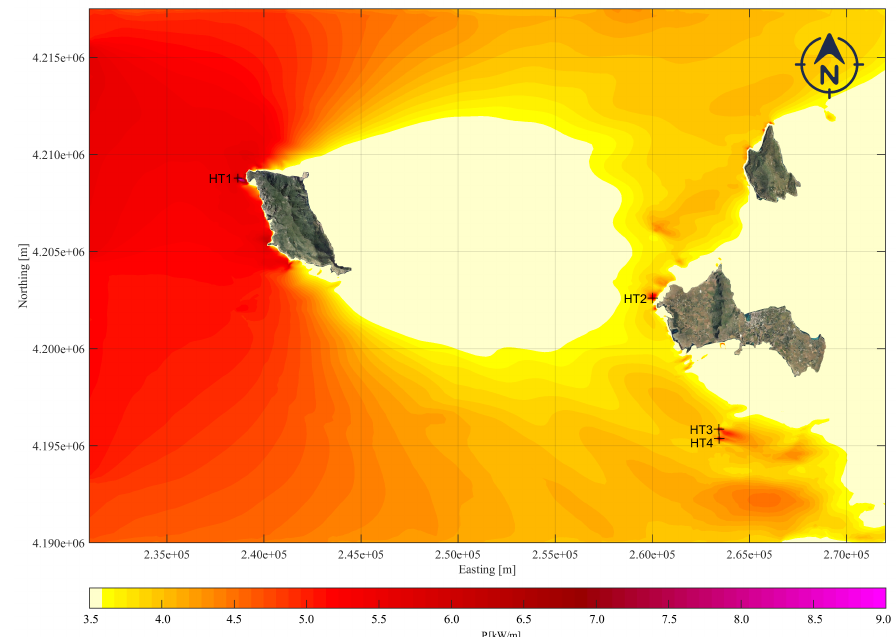
Figure 11. The four energetic hotspots of the Aegadian archipelago in the period between 2009 and 2010. The colour bar shows the mean yearly wave energy flux [kW/m], the crosses represent the hotspots HT1, HT2, HT3 and